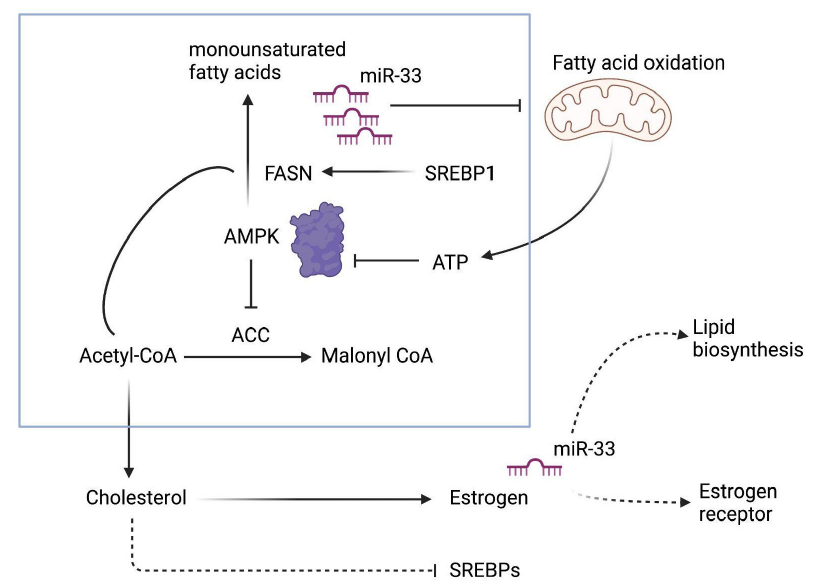
Figure 4. Schematic presentation of miR-33a-mediated regulation of fatty acid mechanism in the presence of estrogen receptors. presence of estrogen